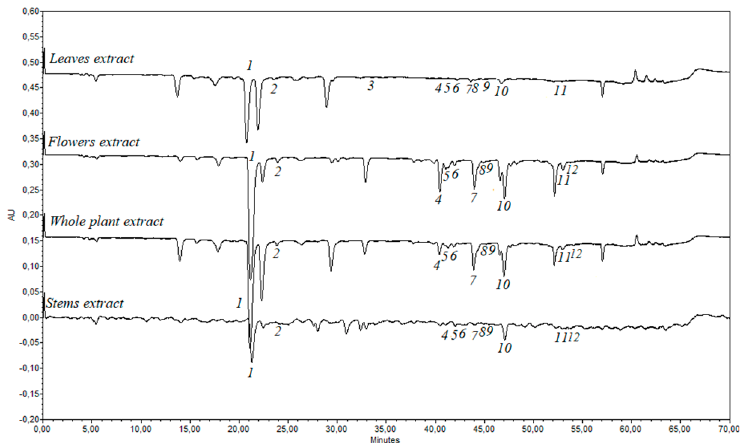
Figure 5. E. ciliata leaves, stems, flowers, and whole herb extracts ABTS post-column assay antiradical profile: 1—chlorogenic acid, 2—caffeic acid, 3— p -coumaric acid, 4—rutin, 5—hyperoside, 6—luteolin-7- O - 12—diosmetin. Table 3. Trolox equivalent (TE) values ( µ mol / g of DW) of E. ciliata ethanolic extracts in ABTS post-column assay. Antioxidant